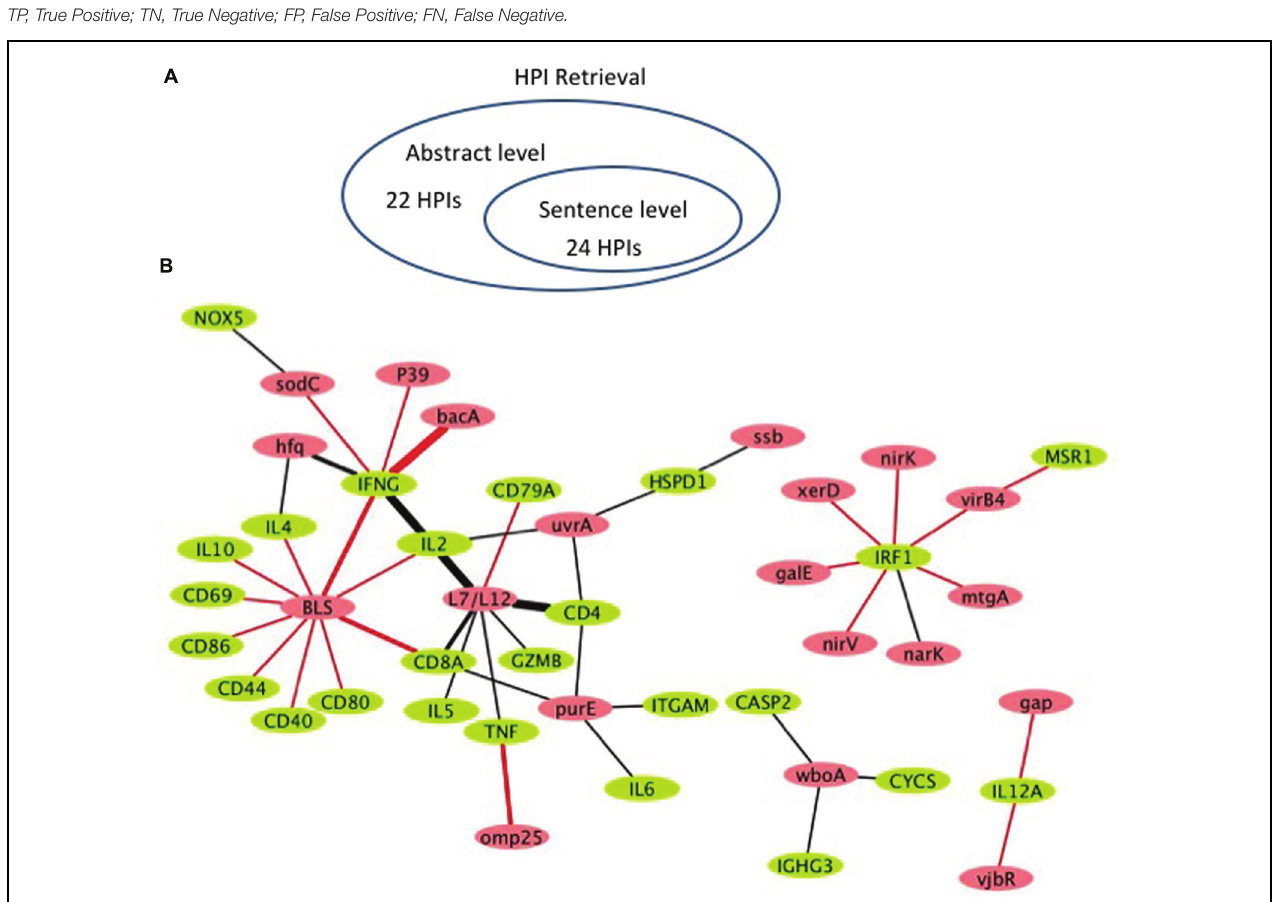
FIGURE 4 | Literature-mined host- Brucella gene–gene interaction results. (A) Venn diagram showing the number of unique host- Brucella interaction gene pairs retrieved and manually verified from sentence-level and abstract-level processing. (B) The literature-mined and manually verified host- Brucella gene–gene interaction network. Host genes are shown in green and Brucella genes are shown in red. Red edges correspond to interactions retrieved from sentence-level processing. Black edges correspond to interactions retrieved from abstract level processing. The more sentences/abstracts describe an interaction between gene pairs the thicker the edge connecting